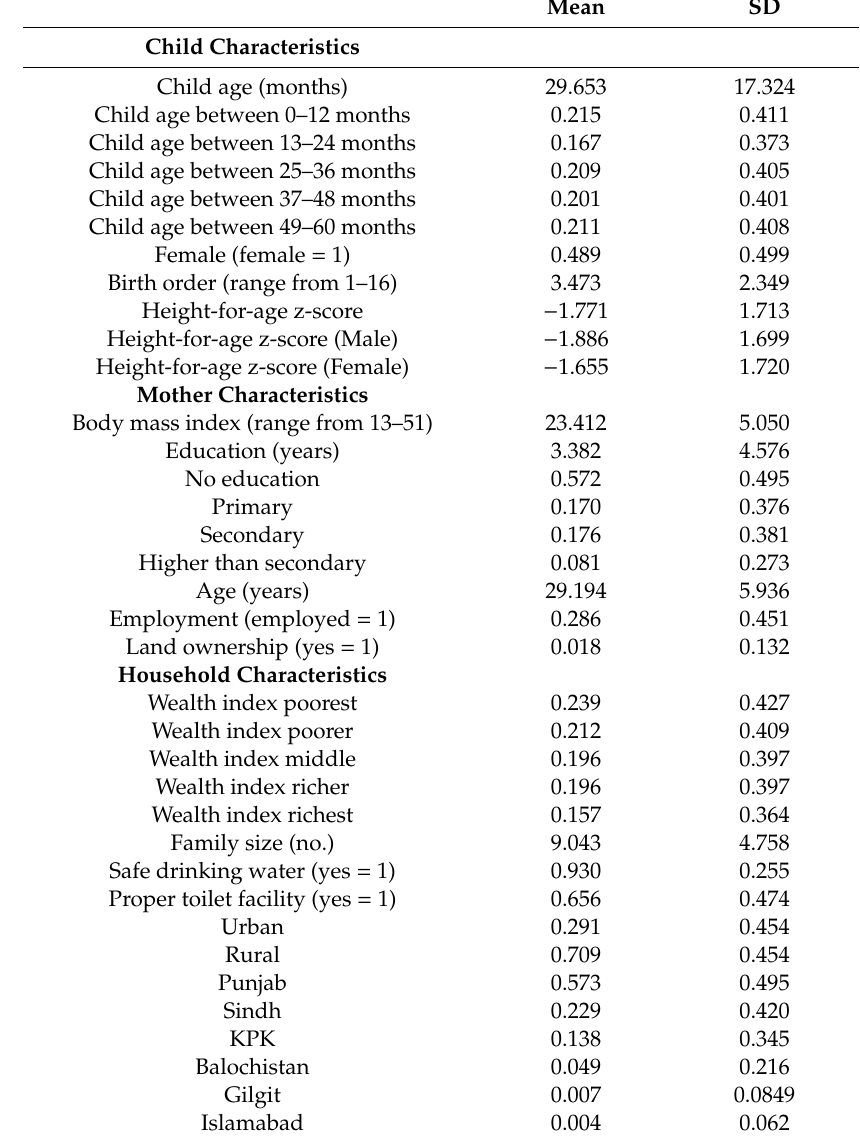
Table 2. Descriptive analysis of the